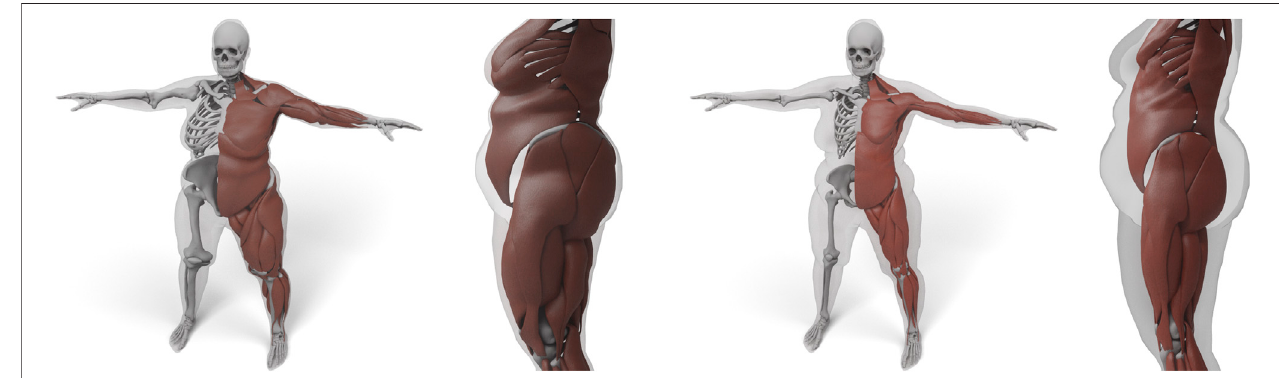
FIGURE 9 | Result of transferring the anatomy by using just the skin layer and a harmonic basis (left) . Here, both muscles and bones deform too much to fi t overweight targets. We use the additional muscle and skeleton layer and a triharmonic basis (right) to prevent unnatural deformations.